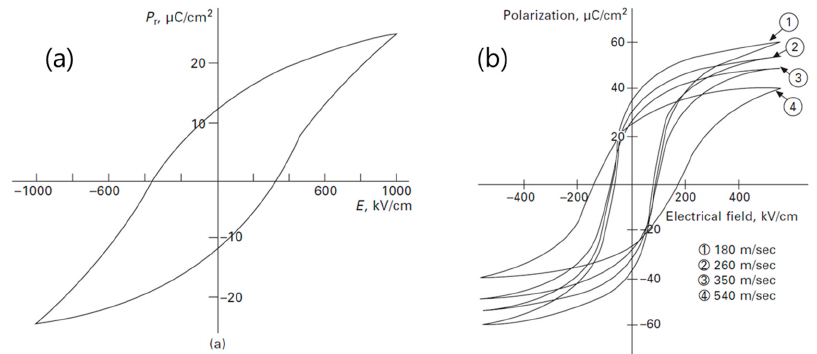
Figure 7. Polarization-electric field ( P - E) hysteresis loops of 5-µm-thick PZT films ( a ) as-deposited and ( b ) after post-annealing at 600 °C with different particle impact velocities [17]. © Copyright 2010, Elsevier.